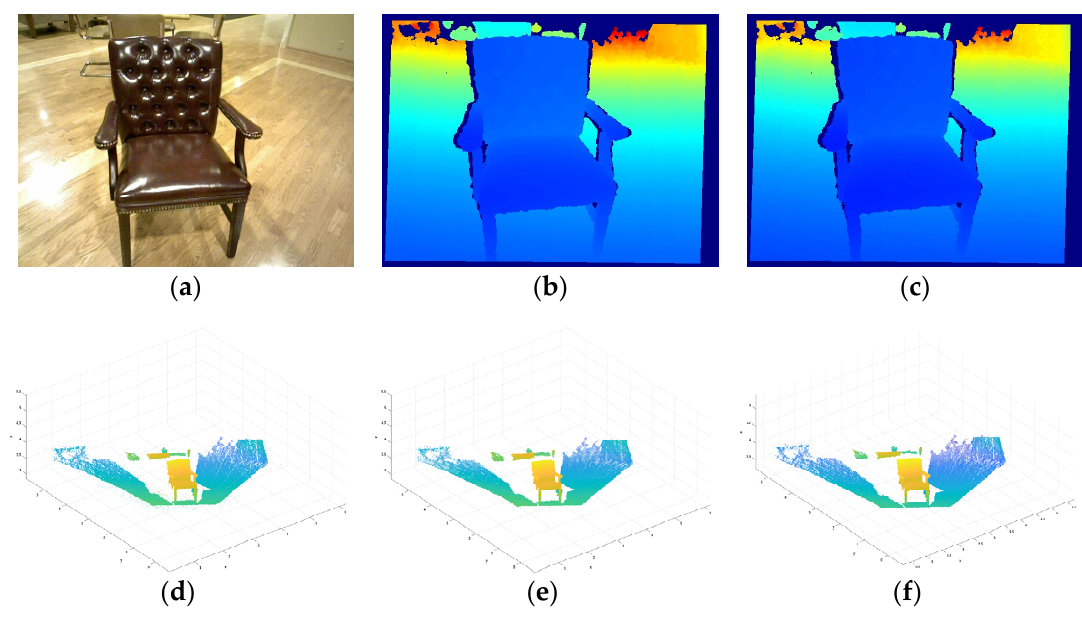
Figure 9. Denoising effects of fractional integral denoising and median filtering. ( a ) RGB image (dataset number 05959); ( b ) deep pseudo-colour map (dataset number 05989); ( c ) noise-free point cloud image; ( d ) point cloud image with added noise, PSNR = 47.307 dB; ( e ) point cloud image filtered by fractional integral denoising ( ν = − 0.3, PSNR = 52.992 dB); and ( f ) point cloud of the depth image after median filtering and denoising (PSNR = 37.480 dB).